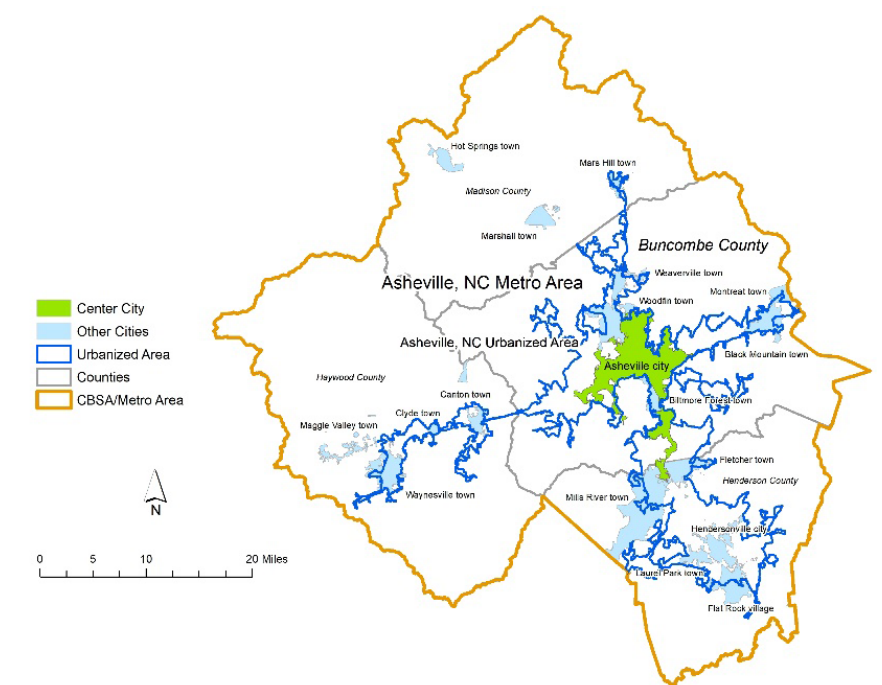
Figure 1. Example of city-urban